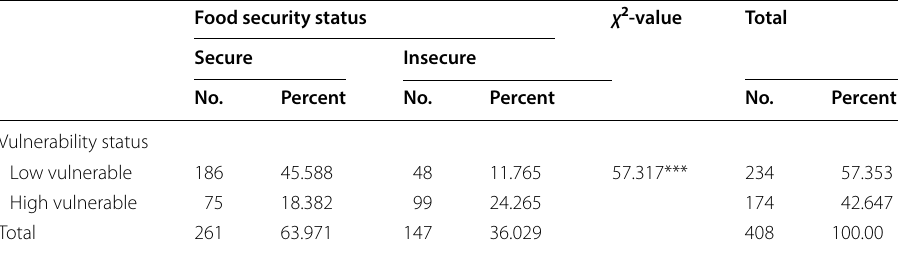
***, ** and * significant at the 1, 5 and 10% probability levels,